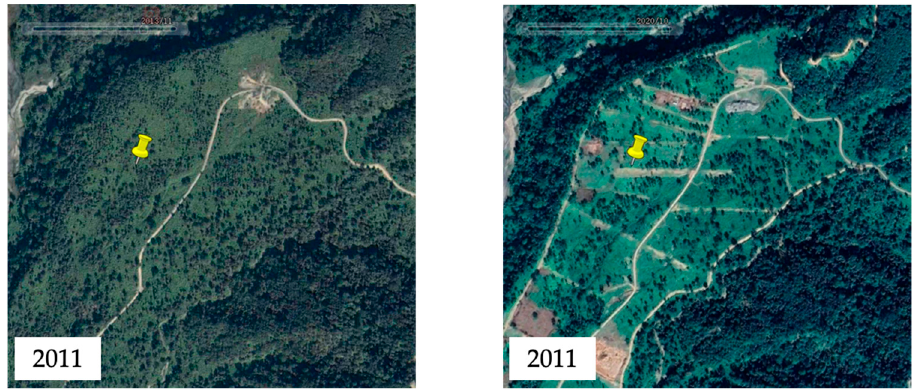
Figure 15. S ate llite imagery from Google Earth Pro at location (91.7642° E, 26.9048° N) . Figure 15. Satellite imagery from Google Earth Pro at location (91.7642 ◦ E, 26.9048 ◦ N).